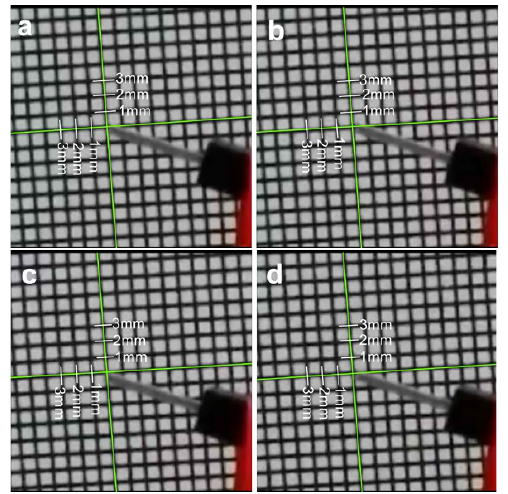
Figure 8. Testing the precision positioning of the actuator. A pin attached to the end of the actuator to indicate its position against the background of a 1 mm × 1 mm grid. ( a ) Initial position. ( b ) Position after the first bending cycle. ( c ) Position after second bending. ( d ) Position after third bending